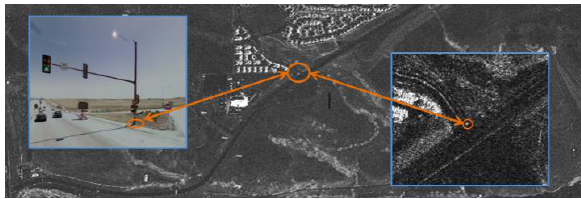
Figure 2. Location of a metal pole in the SAR